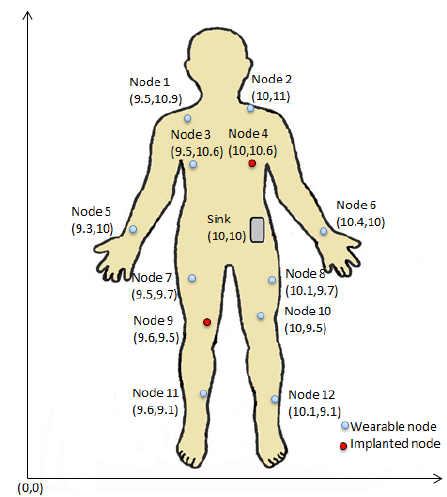
Figure 7. Node locations along with sink